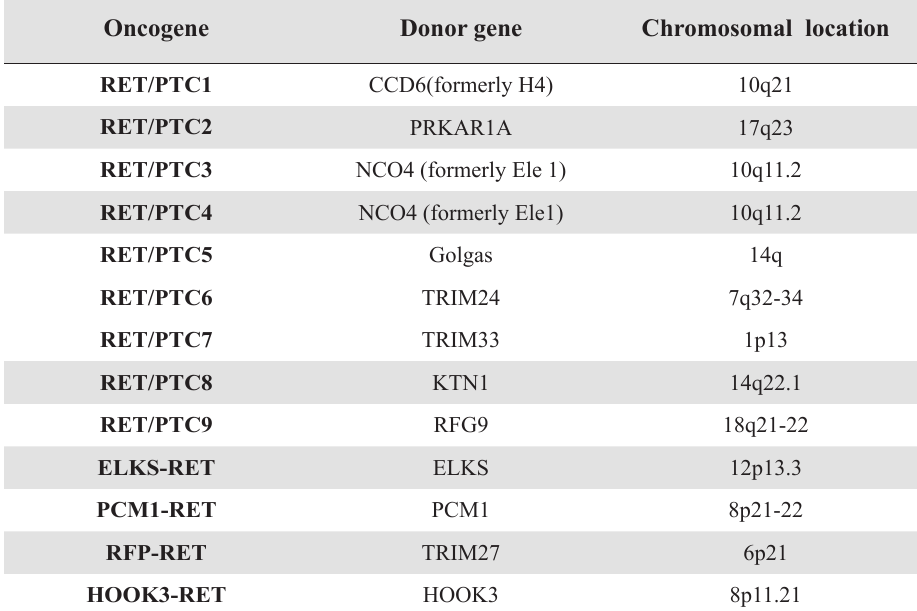
Table 1. Different types of RET/PTC rearrangements in thyroid tumors according to Nikiforov YE